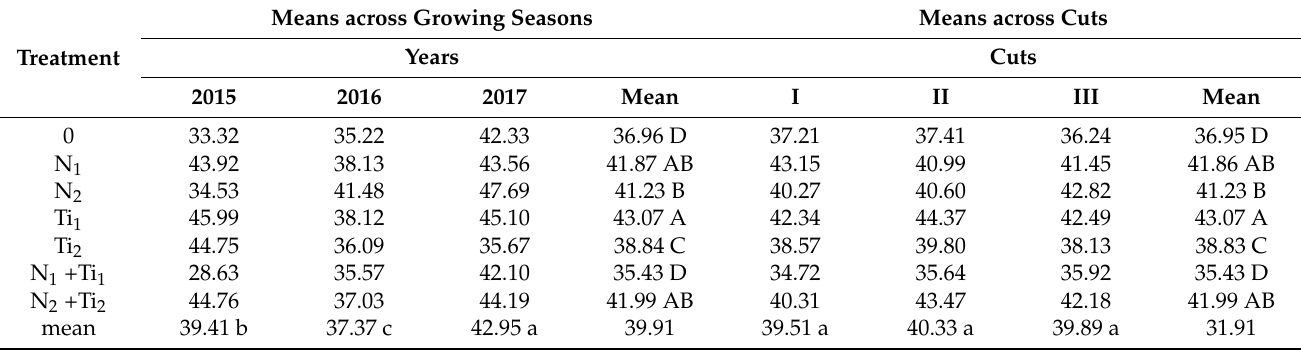
Table 6. Acid detergent lignin (ADL) content in Festulolium braunii (g kg − 1 DM). Means across Growing Treatment